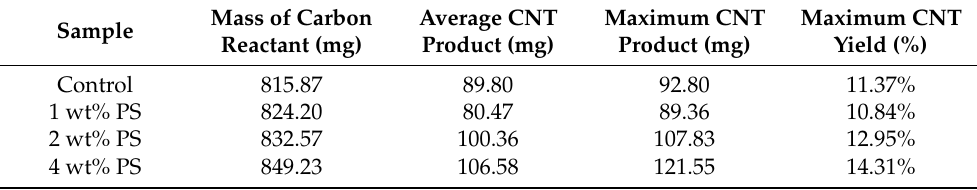
Figure 4. Thermogravimetric data of CNT growth from polystyrene 4 wt% loading, residual mass found to be 6.53%, composed of iron oxide residue from catalyst precursor. Table 2. Mass data and percentage yield results for CNTs grown using